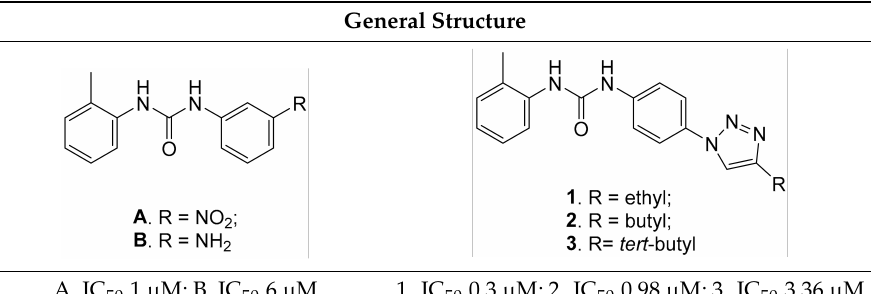
Table 1. Selected diarylurea derivatives as DDX3 inhibitors in